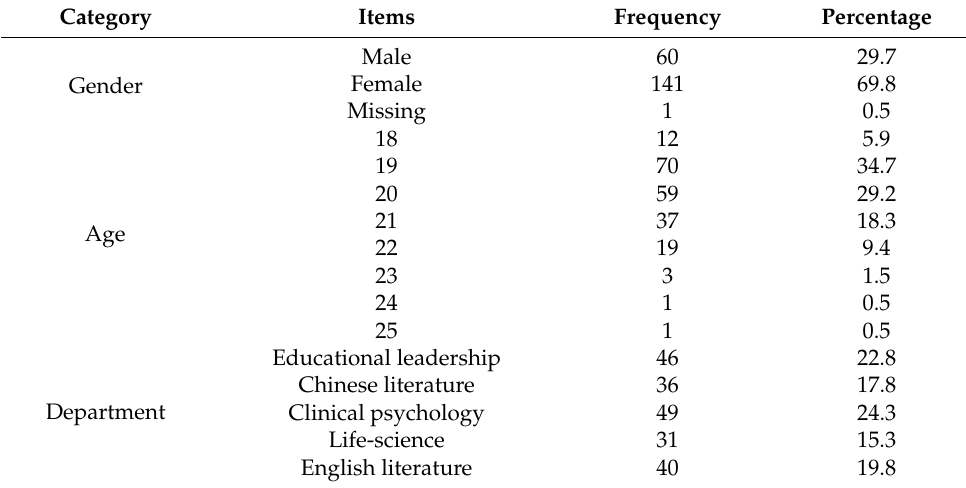
Table 1. Sample demographics (Study